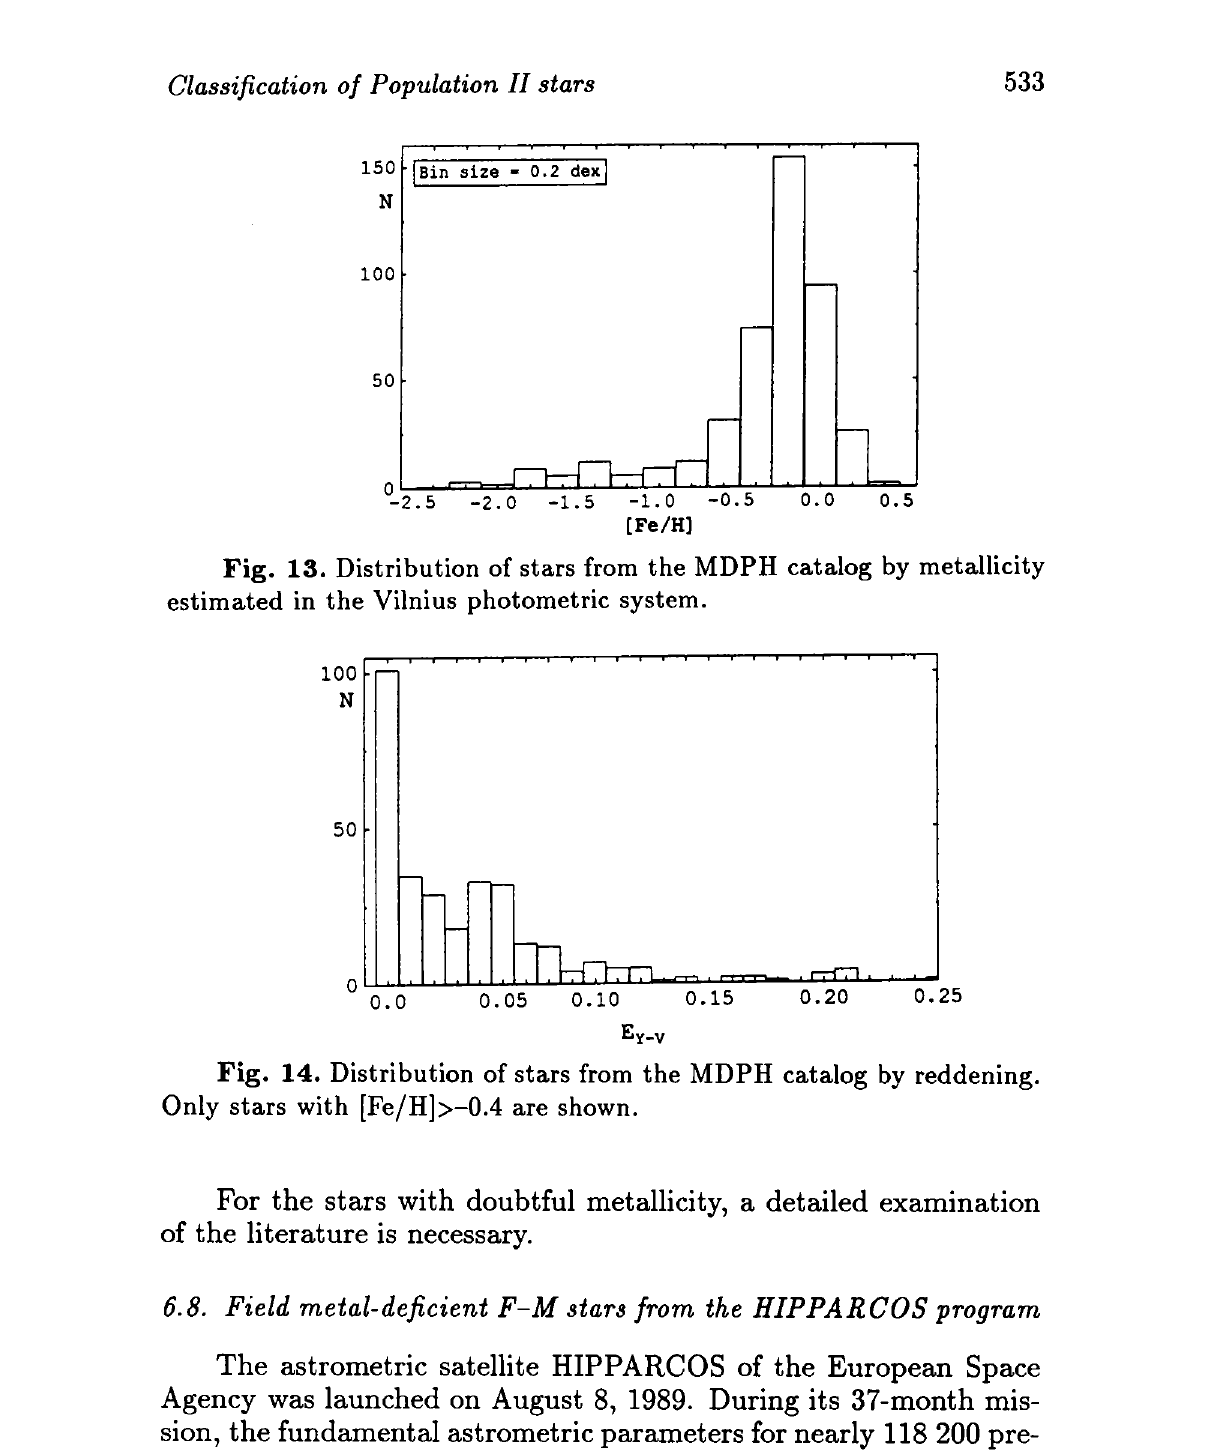
Fig. 14. Distribution of stars from the MDPH catalog by reddening. Only stars with [Fe/H]>-0.4 are